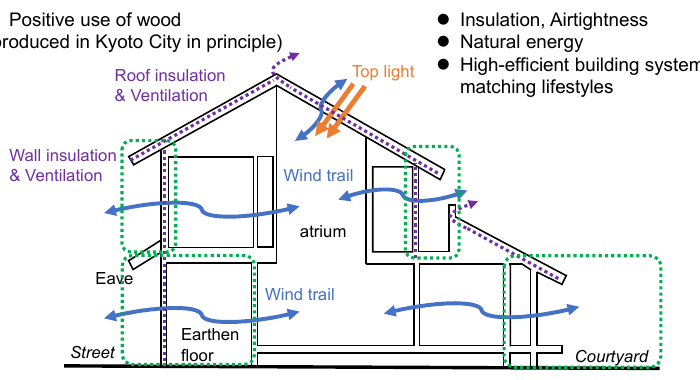
Figure 3. Concept of the “Heisei-no-Kyo-machiya” (depicted by authors based on a website [27]). In a “Kyo-machiya”, the relationship between the inside and outside is crucial to maintain which of the connecting spaces, including the “Tori-niwa” and “Engawa” (ve- randa), are adjusted in the indoor environment. Through this relationship, a fruitful living culture is cultivated depending on the season. The “Heisei-no-Kyo-machiya” concept aims to improve the design of this intermediate region that connects the inside and outside, creating an “environment adjustment (buffer) space” (Figure 4). In this way, “Heisei-no- Kyo-machiya” retains the relationship between an individual and his/her environment, and that between a residence and the surrounding area, with an “environment adjusting space” intervening between them.